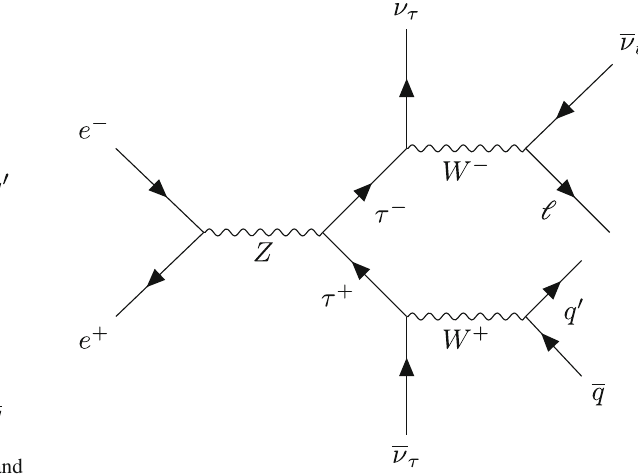
Fig. 2 The Feynman diagram of the τ + τ −